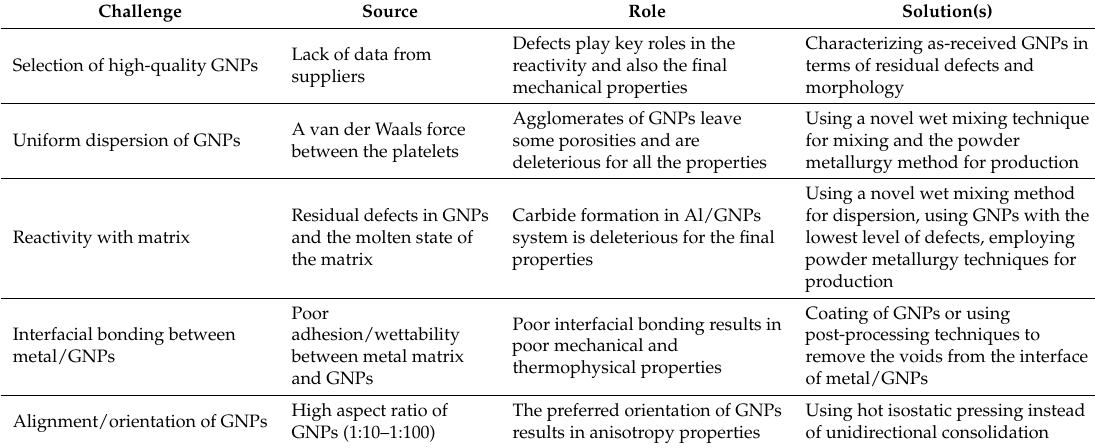
Table 1. The technical challenges in the fabrication of metal matrix nanocomposites (MMNCs) reinforced with graphene nanoplatelets